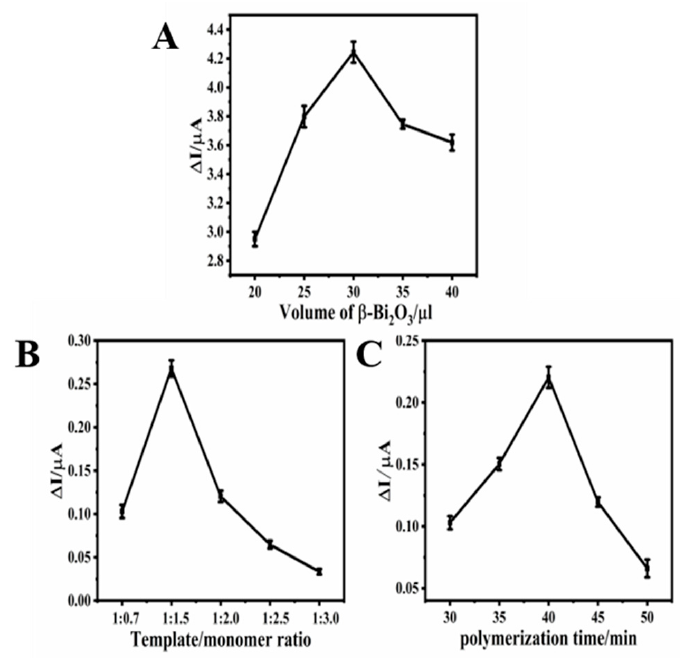
Figure 3. Optimization of ( A ) modification volume of β -Bi 2 O 3 ; ( B ) template/monomer ratio. ( C ) self-polymerization time. The concentration of BPA is 10 nM.